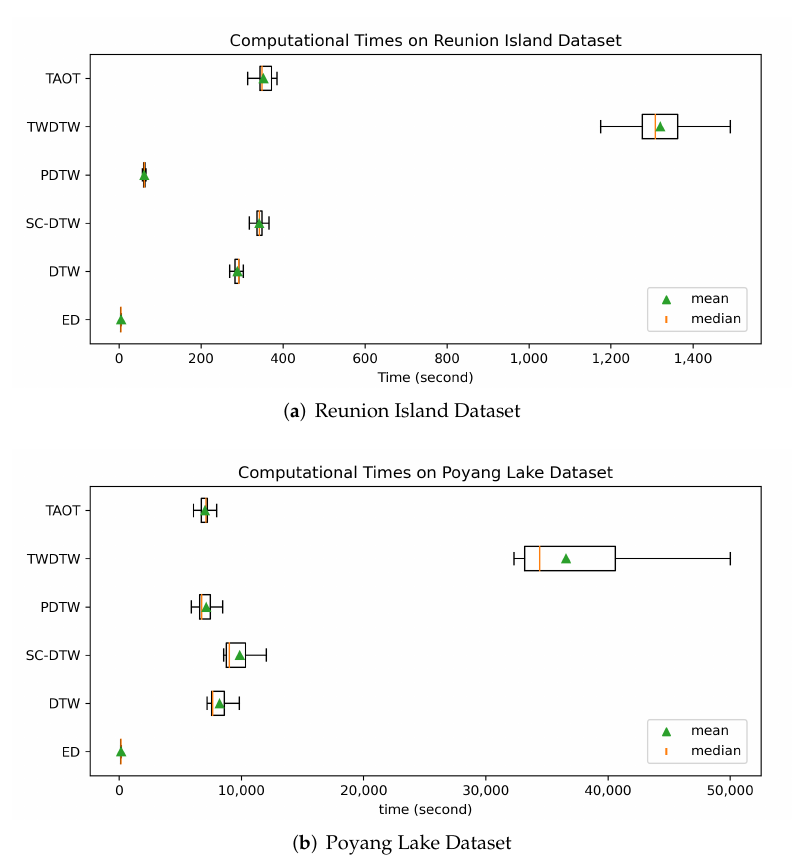
Figure 13. Computational times of different methods on the two datasets. ( a ) Reunion Island Dataset; ( b ) Poyang Lake